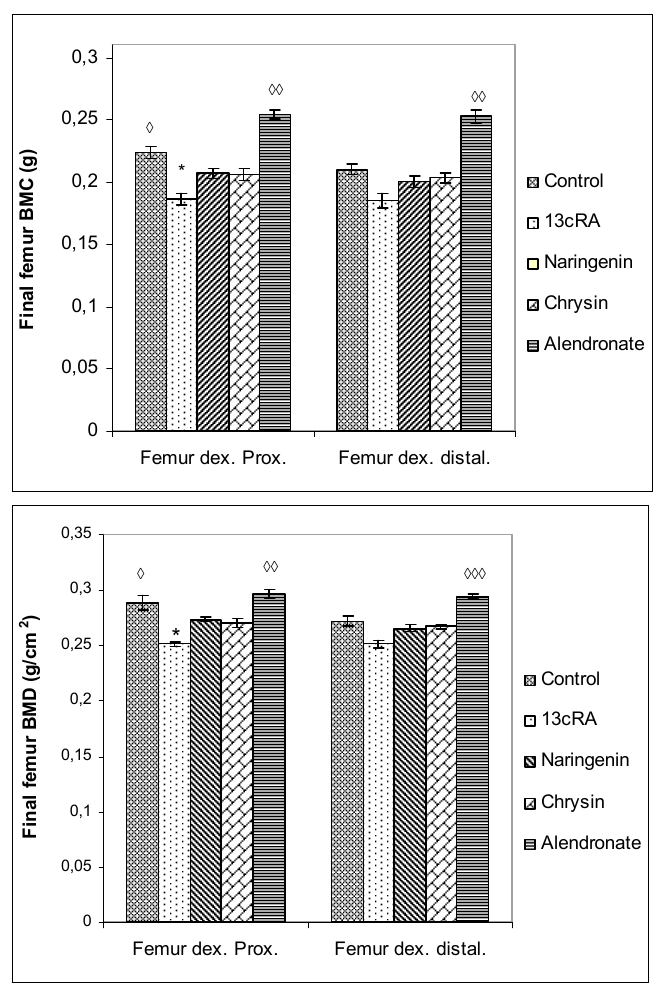
Figure 5. Effects of naringenin, chrysin, or alendronate on bone mineral content (BMC) and bone mineral density (BMD) in rats with retinoic-acid-induced osteoporosis. Rats were administered ig with retinoic acid (13cRA) suspension (80 mg/kg) once daily for 14 days. After inducing osteoporosis with 13cRA, rats were administered ig with naringenin (100 mg/kg), chrysin (100 mg/kg), or alendronate (40 mg/kg), once daily for the next 14 days. BMC and BMD were assessed using dual-energy X-ray absorptiometry (DXA) and left femurs. BMD was calculated as BMC divided by the measured area and reported as g/cm 2 . Results are expressed as means of seven samples per group ( n = 7) ± SEM. Data were analysed by the Kruskal–Wallis test. *—Statistically significant compared with Control ♦ ♦ p ♦♦ p ♦♦♦ p (* p < 0.05). —Statistically significant compared with 13cRA ( < 0.05; < 0.01; < 0.001). Administration of naringenin or chrysin did not improve 13cRA-induced decrease in BMC and BMD values in the proximal metaphysis region. However, a trend towards beneficial effects of naringenin and chrysin is evident for both BMC and BMD in the proximal part of the metaphysis of the femur (Figure